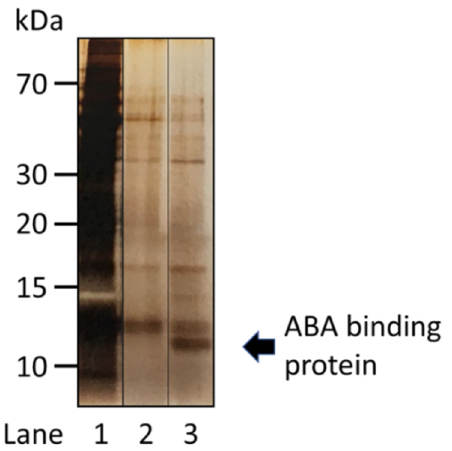
Figure 3. Isolation of an ABA binding protein in A.thaliana . After the incubation of a protein extract of A. thaliana with 5 , bio-orthogonal coupling of 2 to 5 was performed, and the ternary complex was connected by DTSSP 4 . The ternary complex was bound with a streptavidin sepharose. The proteins in each fraction were analyzed by SDS-PAGE and then visualized by silver staining. Lane 1: pass through; lane 2: wash (50 mM phosphate buffer (pH 7.8) with 100 mM NaCl and 2 M urea); lane 3: elution (50 mM phosphate buffer (pH 7.8) with 100 mM NaCl, 2 M urea and 100 mM DTT).